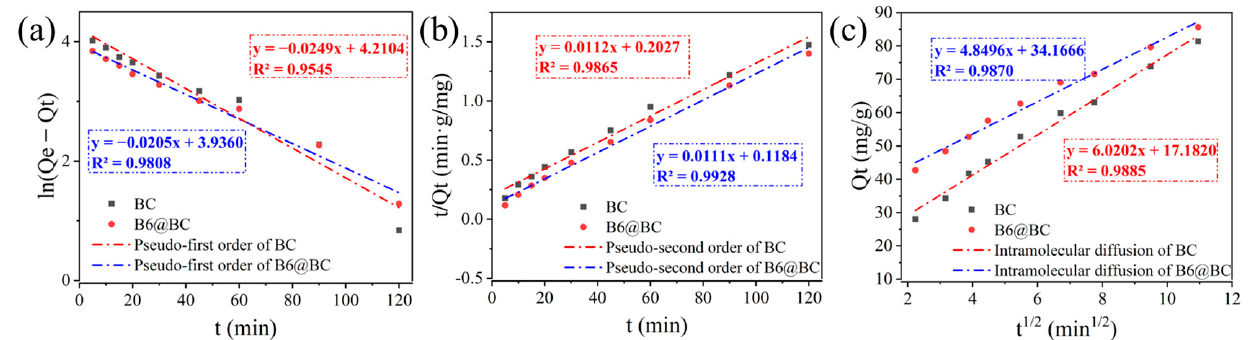
Figure 6. The equilibrium of ( a ) original adsorption capacity and adsorption isotherm modelling ( b ) Langmuir isotherm, ( c ) Freundlich isotherm, and ( d ) Temkin isotherm of OTC on BC and B6@BC.